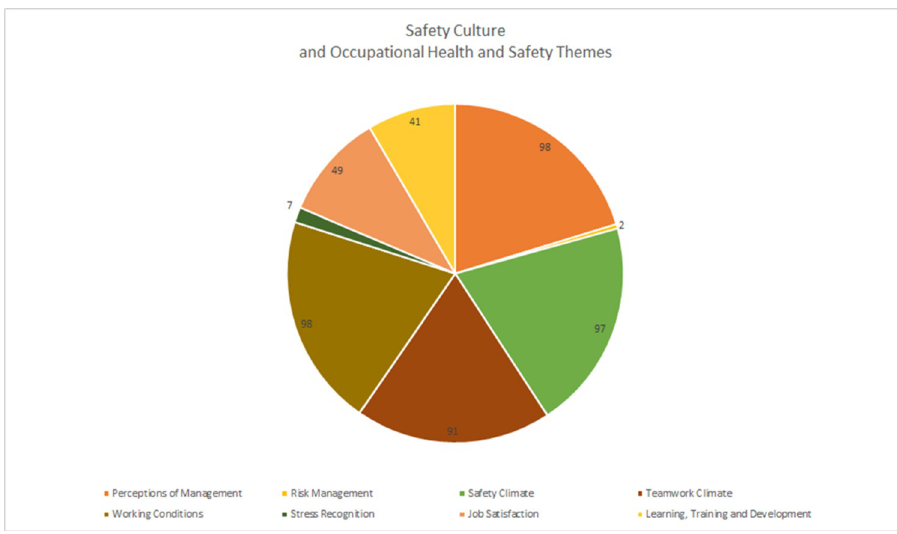
Fig 2. Distribution of key themes from employee online reviews (n = 103).